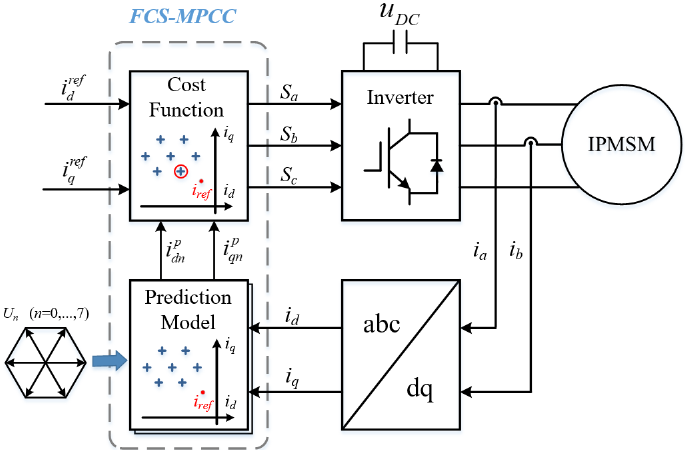
Figure 1. Block diagram of finite-control-set model predictive current control (FCS-MPCC) scheme.